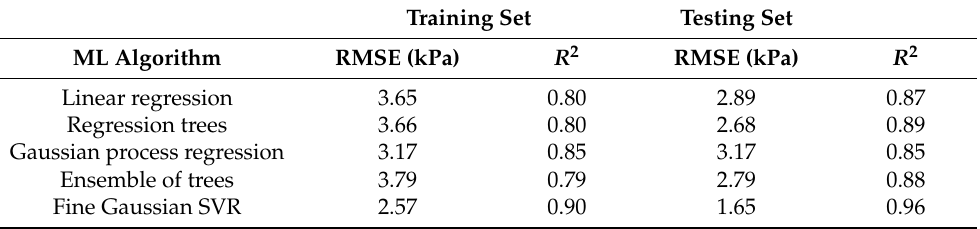
Figure 5. Correlation chart of soft clay features. Table 2. Evaluation metrics of soft clay ML models for both the training and testing